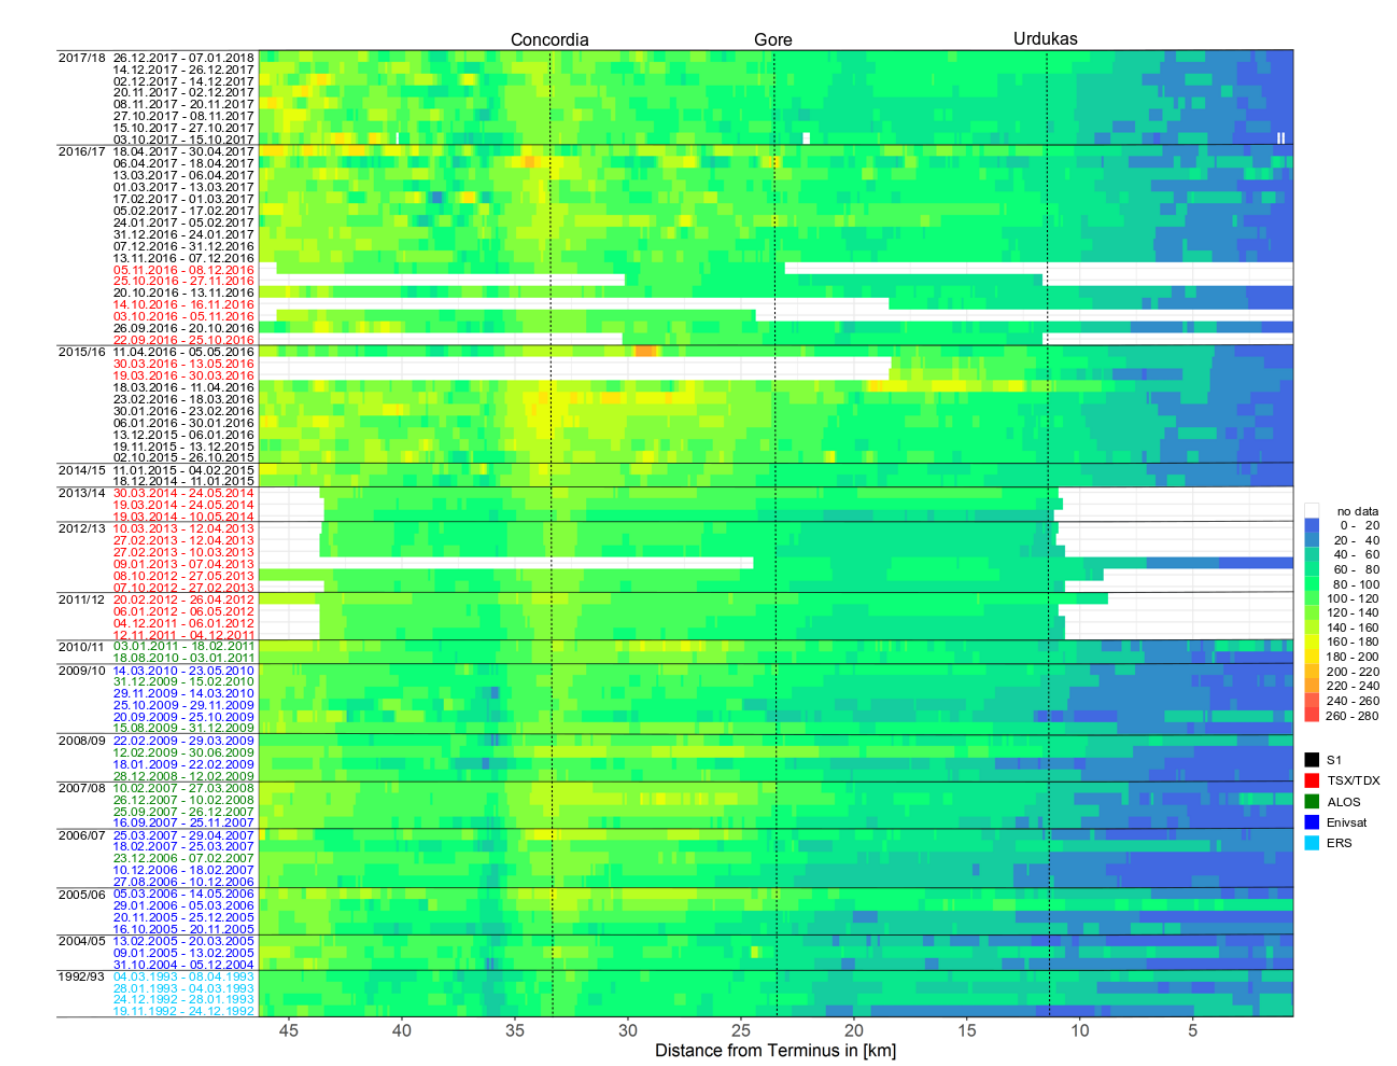
Figure 6. Heatmap of winter surface velocities (m a − 1 ) from October to April along the glacier